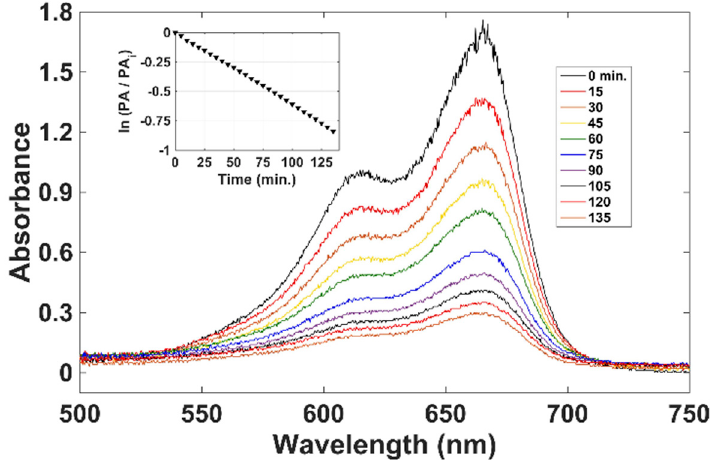
Figure 3. Visible absorption spectra of methylene blue (MB) solution during irradiation in the presence of photocatalytic beads, showing loss of MB from solution as a function of time. Inset plot shows the natural log of the peak area ratio as a function of time suggesting the removal rate of MB is first-order. The beads used are made with a 5% TiO 2 :PDMS mass ratio in the emulsion.